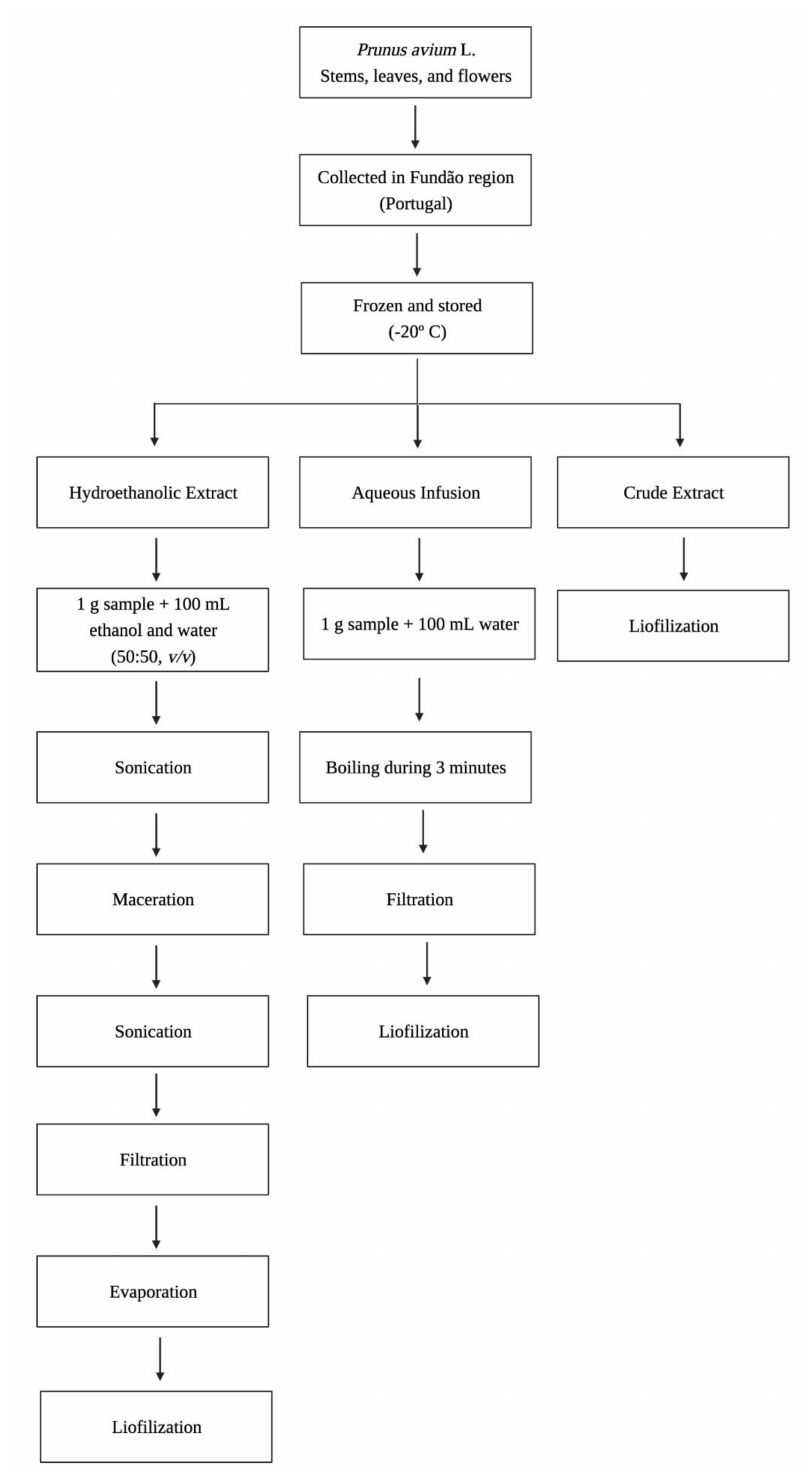
Figure 1. Scheme of P. avium L. by-product hydroethanolic extract, aqueous infusion, and crude extract